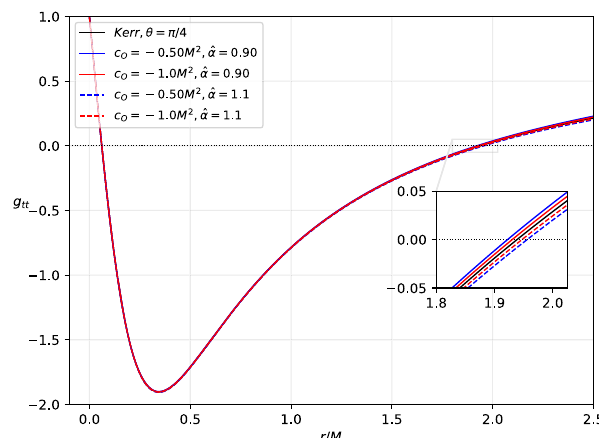
the behavior of AdS (dS) black holes. We consider only negative values of c O in agreement with